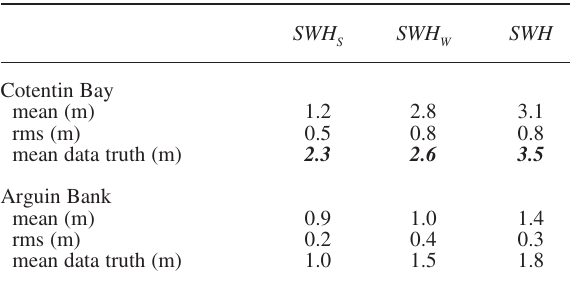
position of the swell peaks of the SAR modulation spectrum (Forget et al. , 1995), we checked the qual- ity of our estimates by comparing them with the val- ues deduced from the dispersion relationship in shal- low water. A swell period of 14.5 s was used (Fig. 4). Lines on each part of the first bisector represent a deviation of the standard error of one wavenumber sample width (± ∆ k = 0.002 rad/m). With small wavenumbers the estimate agrees well with a stan- dard deviation of the order of ∆ k . As the wavenum- ber increases, the SAR estimates are found to be smaller than the theoretical values (Forget et al.